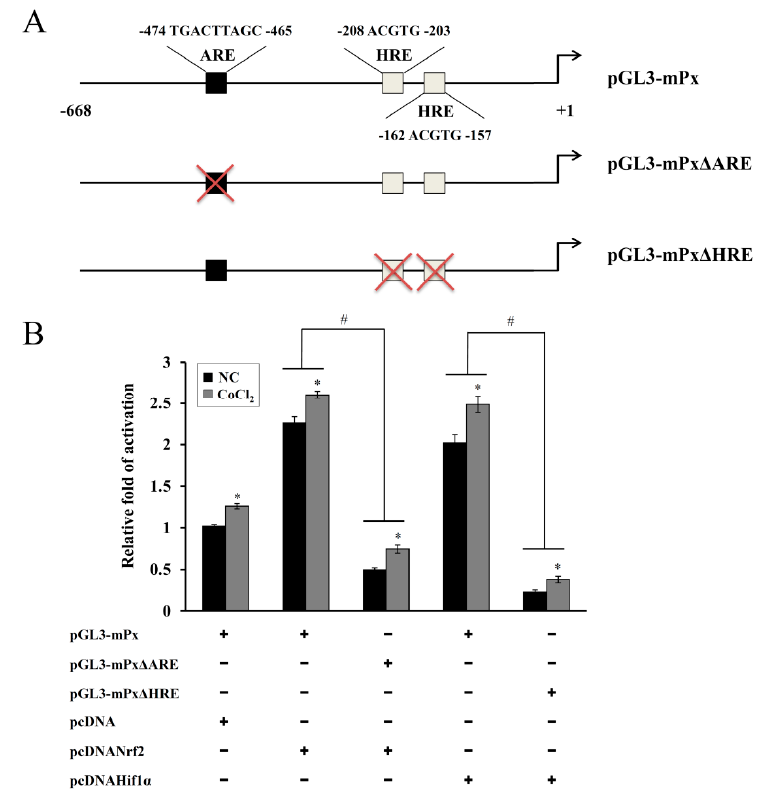
Figure 6. Role of the HRE and ARE in Prdx6 gene expression. ( A ) Schematic illustration of the Prdx6 promoter containing ARE and two HRE sites (a black box for Nrf-2 binding site, white boxes for